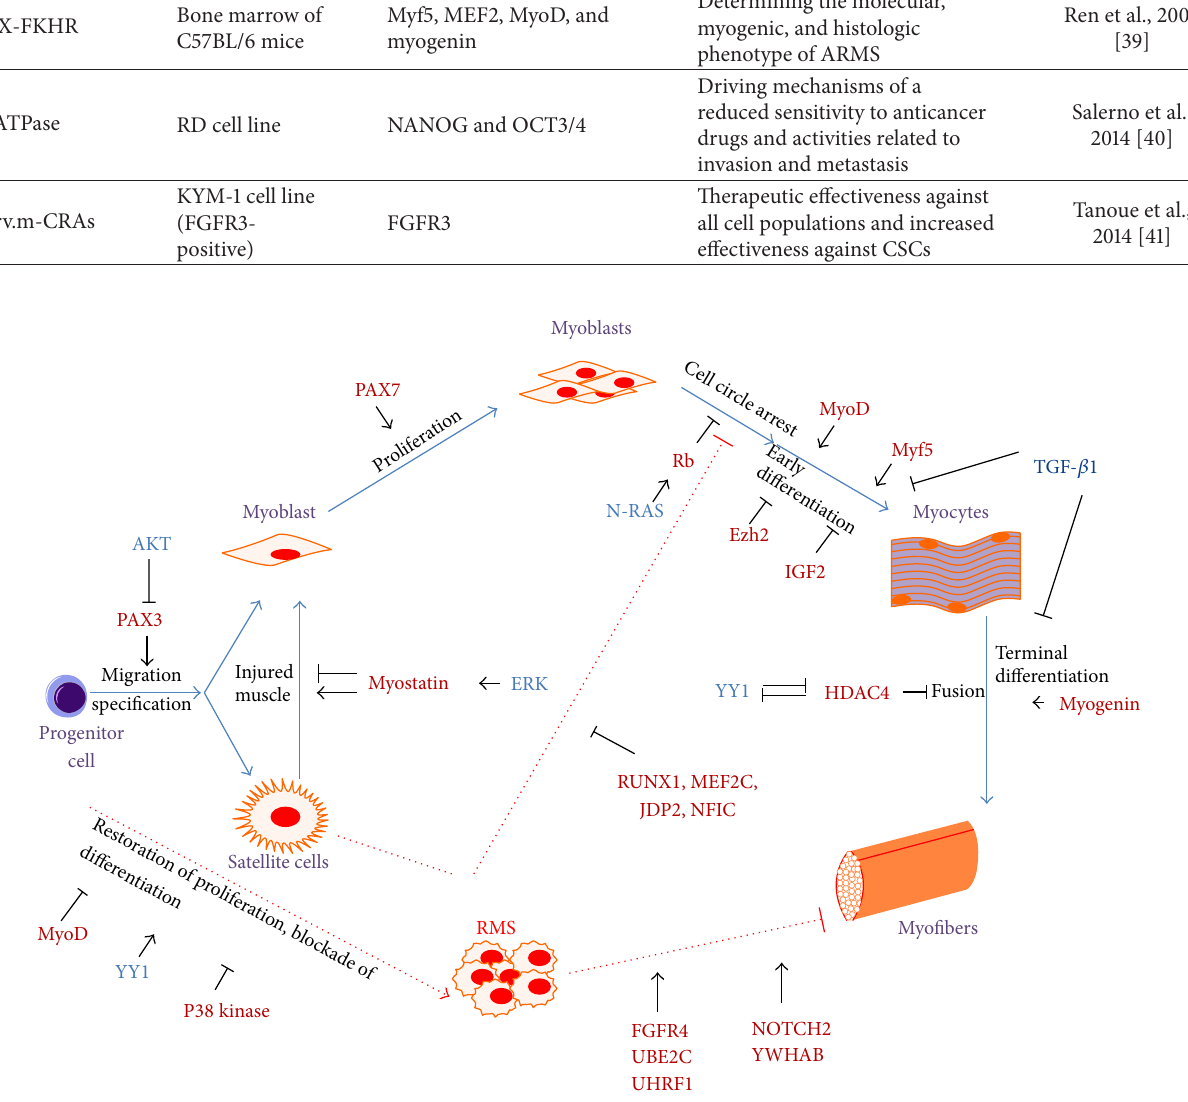
Figure 2: Myogenic pathways in the tumorigenesis of RMS. In aberrant neoplastic condition, progenitor cells residing in muscle result in aberrant pathways, which lead to malignant transformation and fail to differentiate, proliferate uncontrollably, and form RMS. Sharp arrows ( → ) indicate upregulation/activation and blunt arrows ( ⊥ ) indicate